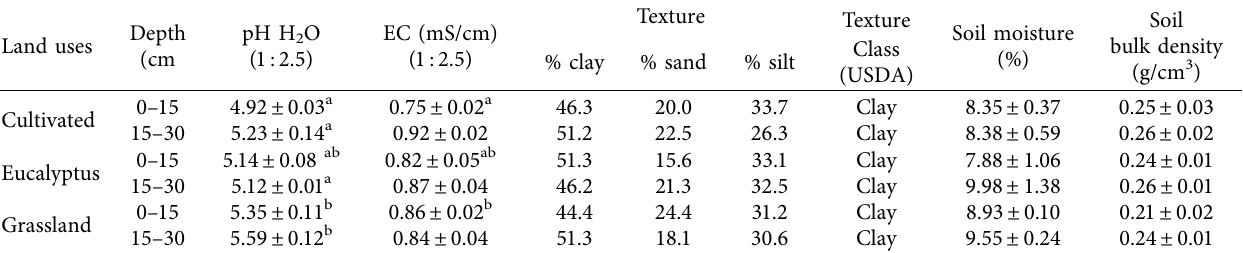
Table 2: Mean ( ± SEM) of selected soil physical properties across land uses and soil depths. Land